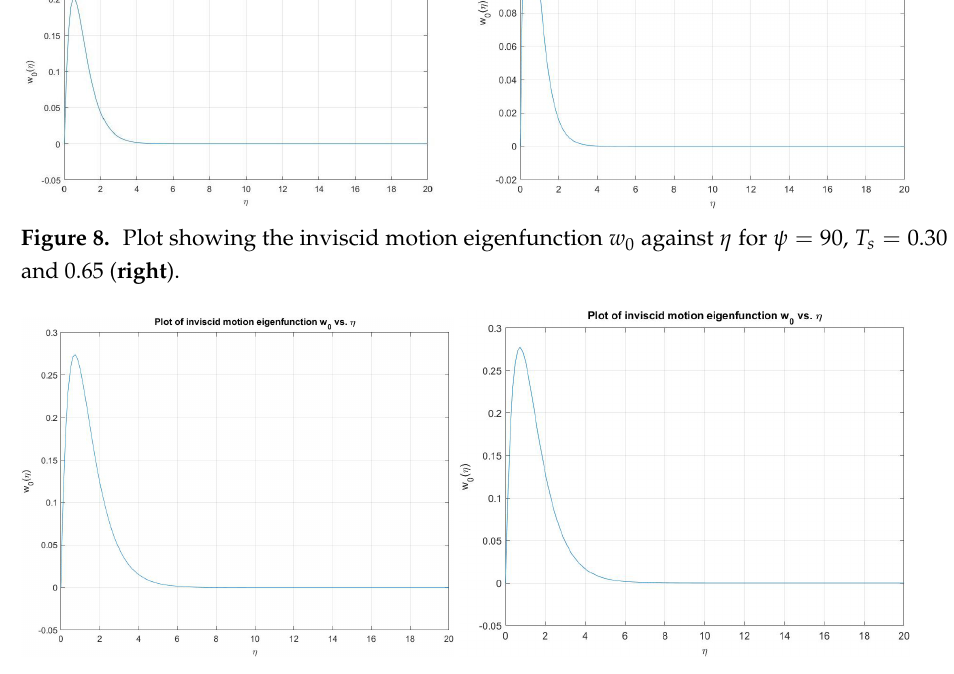
Figure 9. Plot showing the inviscid motion eigenfunction w 0 against η for ψ = 90, T s = − 0.01 ( left ) and − 0.04 ( right ).